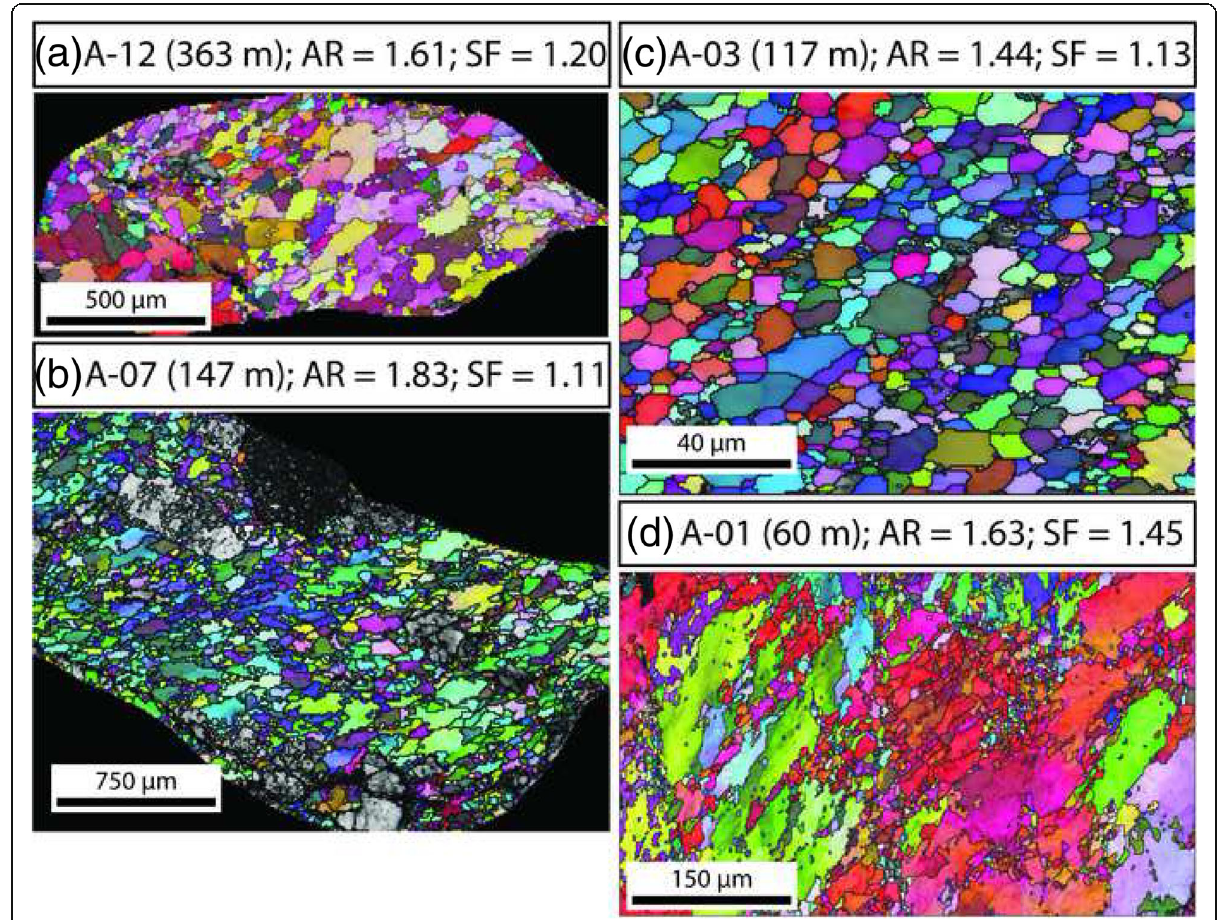
Fig. 8 Variation in quartz microstructure (EBSD inverse pole figure maps) with distance from the MTL in the Ako – Miyamae area ( a – d ). See Fig. 7 for an explanation of the colour